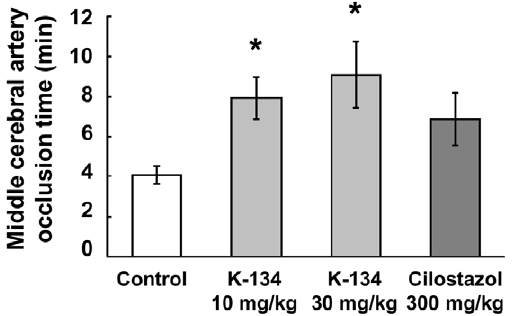
Figure 1. Inhibitory effects of K-134 on middle cerebral artery occlusion time in a photothrombotic stroke model. Preadminis- tration of K-134 but not cilostazol significantly prolonged MCA occlusion time in a photothrombotic cerebral infarction model in comparison with vehicle-treated controls. Values are means 6 SEM (* P , 0.05, two-tailed Dunnett’s test, n =12).